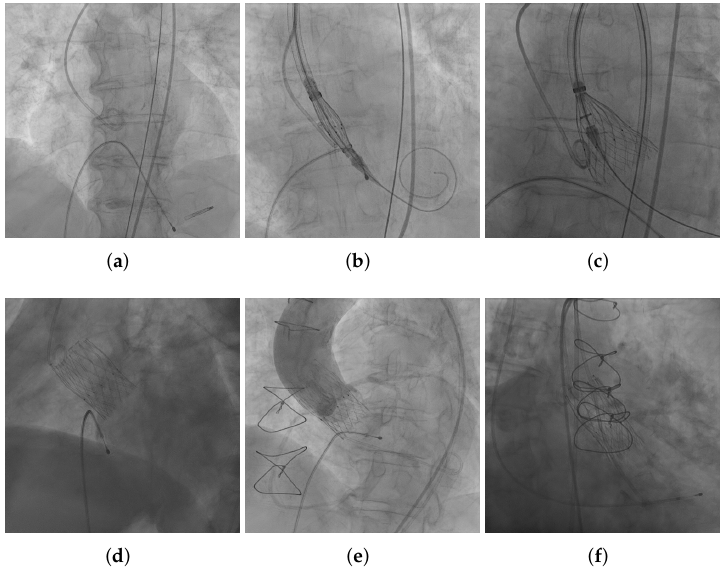
Figure 2. Angiographic frames captured during TAVI. ( a ) Aortic root previous to the device delivery with a pigtail catheter in the non-coronary sinus, and a temporary pacemaker lead in the right ventricle. ( b ) THV loaded in the delivery catheter and positioned in the aortic annulus before deployment. ( c ) First part of the THV deployment in the aortic annulus. ( d ) THV completely deployed in the aortic annulus. ( e ) Functioning assessment of a deployed THV using a contrast agent injection. ( f ) Other elements overlaping the device (previous surgical sutures at the level of the sternum and a temporary pacemaker lead in the right